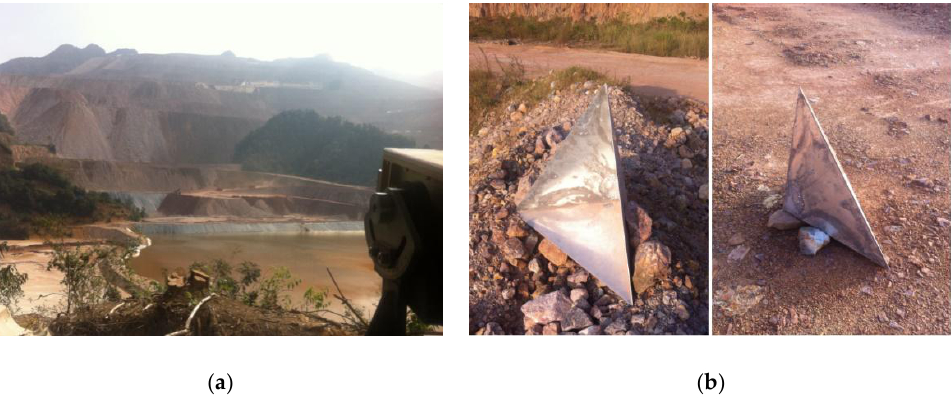
Figure 8. Deformation monitoring for case study 2: ( a ) the monitoring scene and ( b ) corner reflectors.